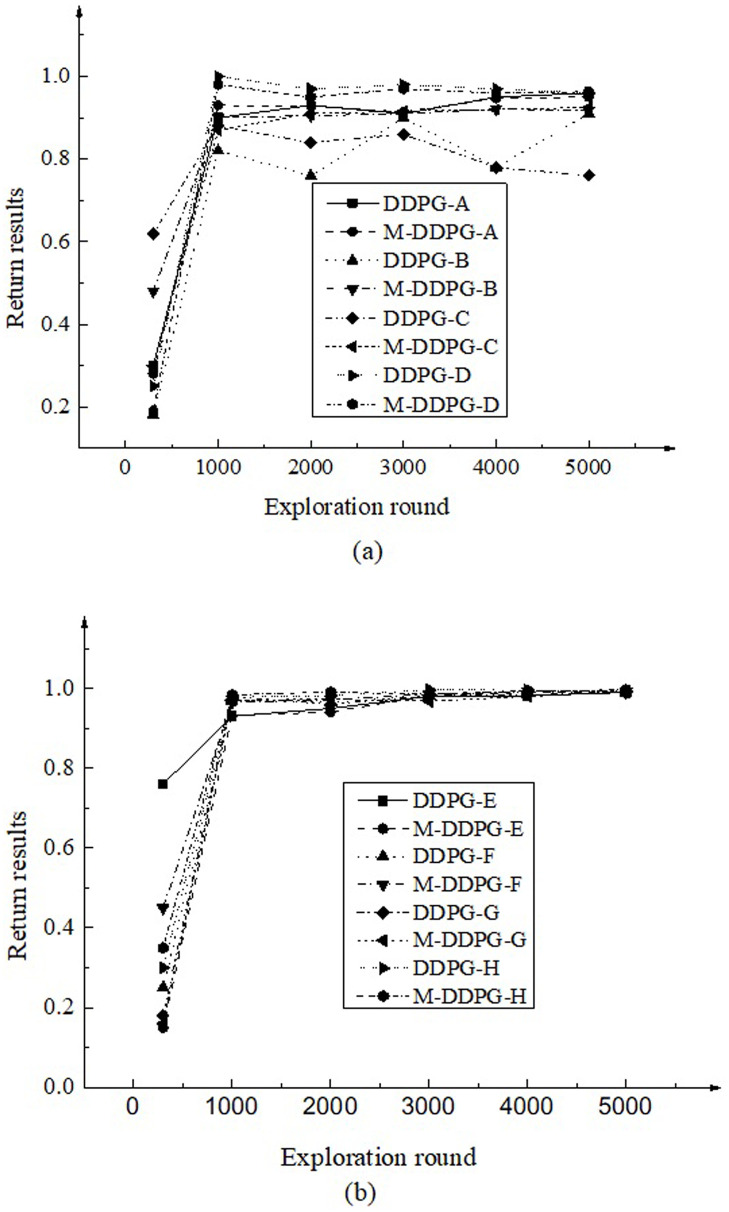
Performance test results of M-DDPG algorithm under 8 tasks (A-D represents fast straight forward, fast-forward-right turn, fast-forward-left turn, and fast straight backward; E-H respectively represents slow straight forward, slow-forward-right turn, slow-forward-left turn, and slow straight backward).